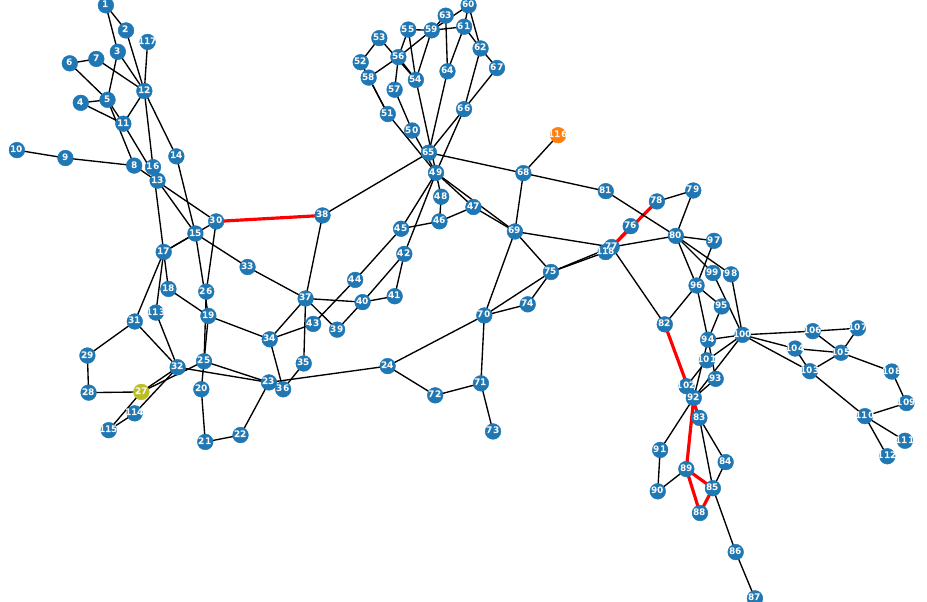
Figure 15. The optimal new 1 × 150 MW RES and mobile MSSSC allocation during Season 3. Red lines indicate the mobile MSSSC deployment locations; the light green node indicates the RES location without devices, and the orange node indicates the RES location with